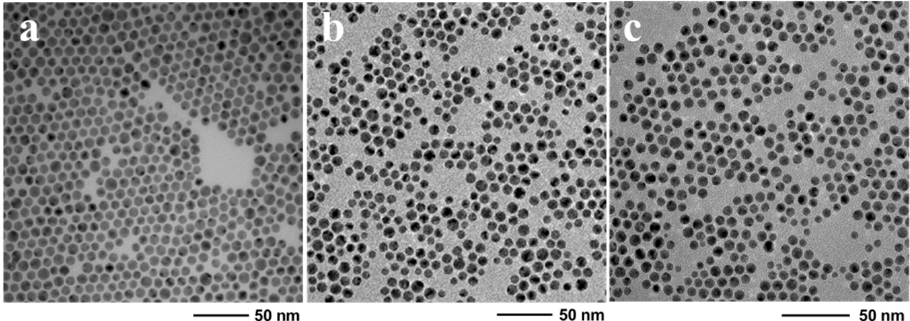
Figure 4. TEM images of Au NPs obtained using ( a ) n-hexane, ( b ) tetralin and ( c ) diphenyl ether as the solvent, respectively.